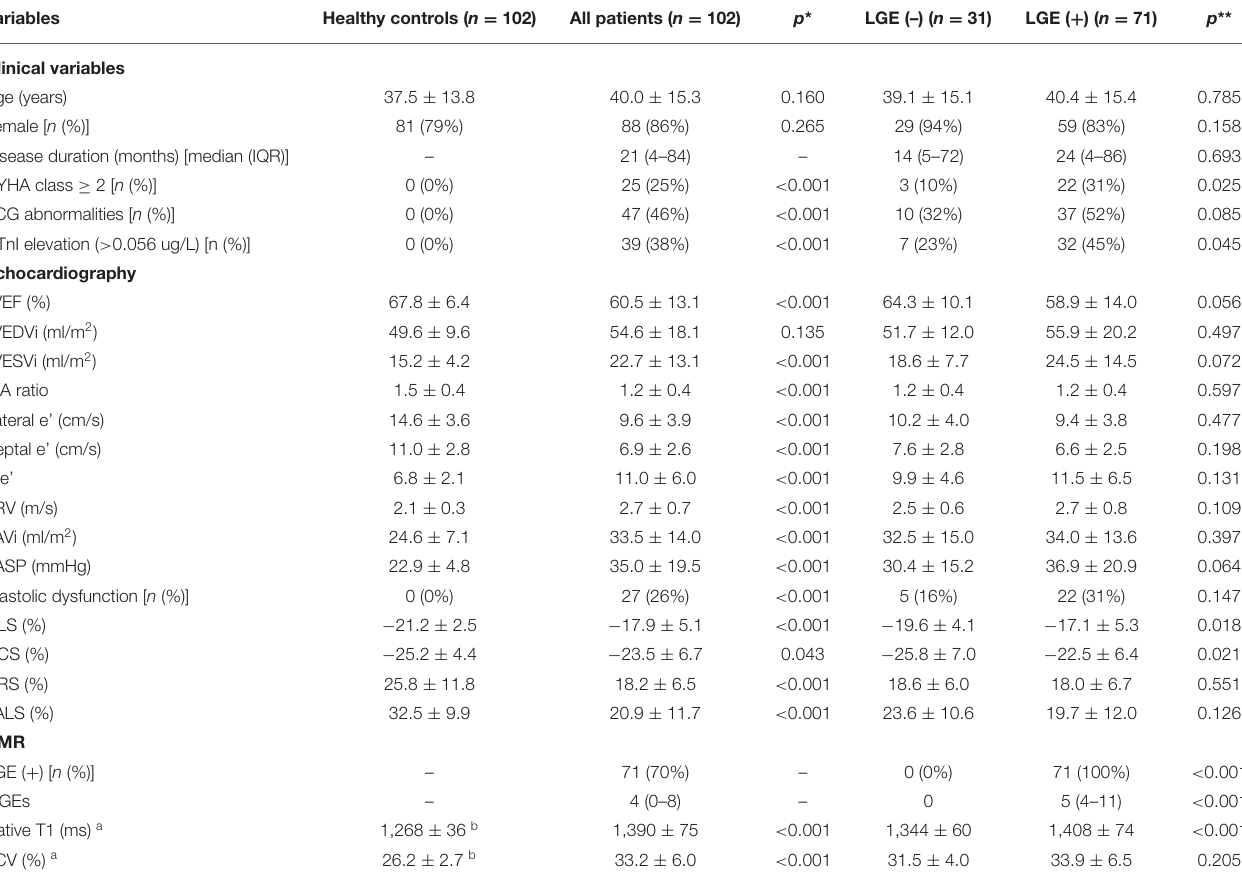
TABLE 2 | Comparison of clinical and imaging parameters of study